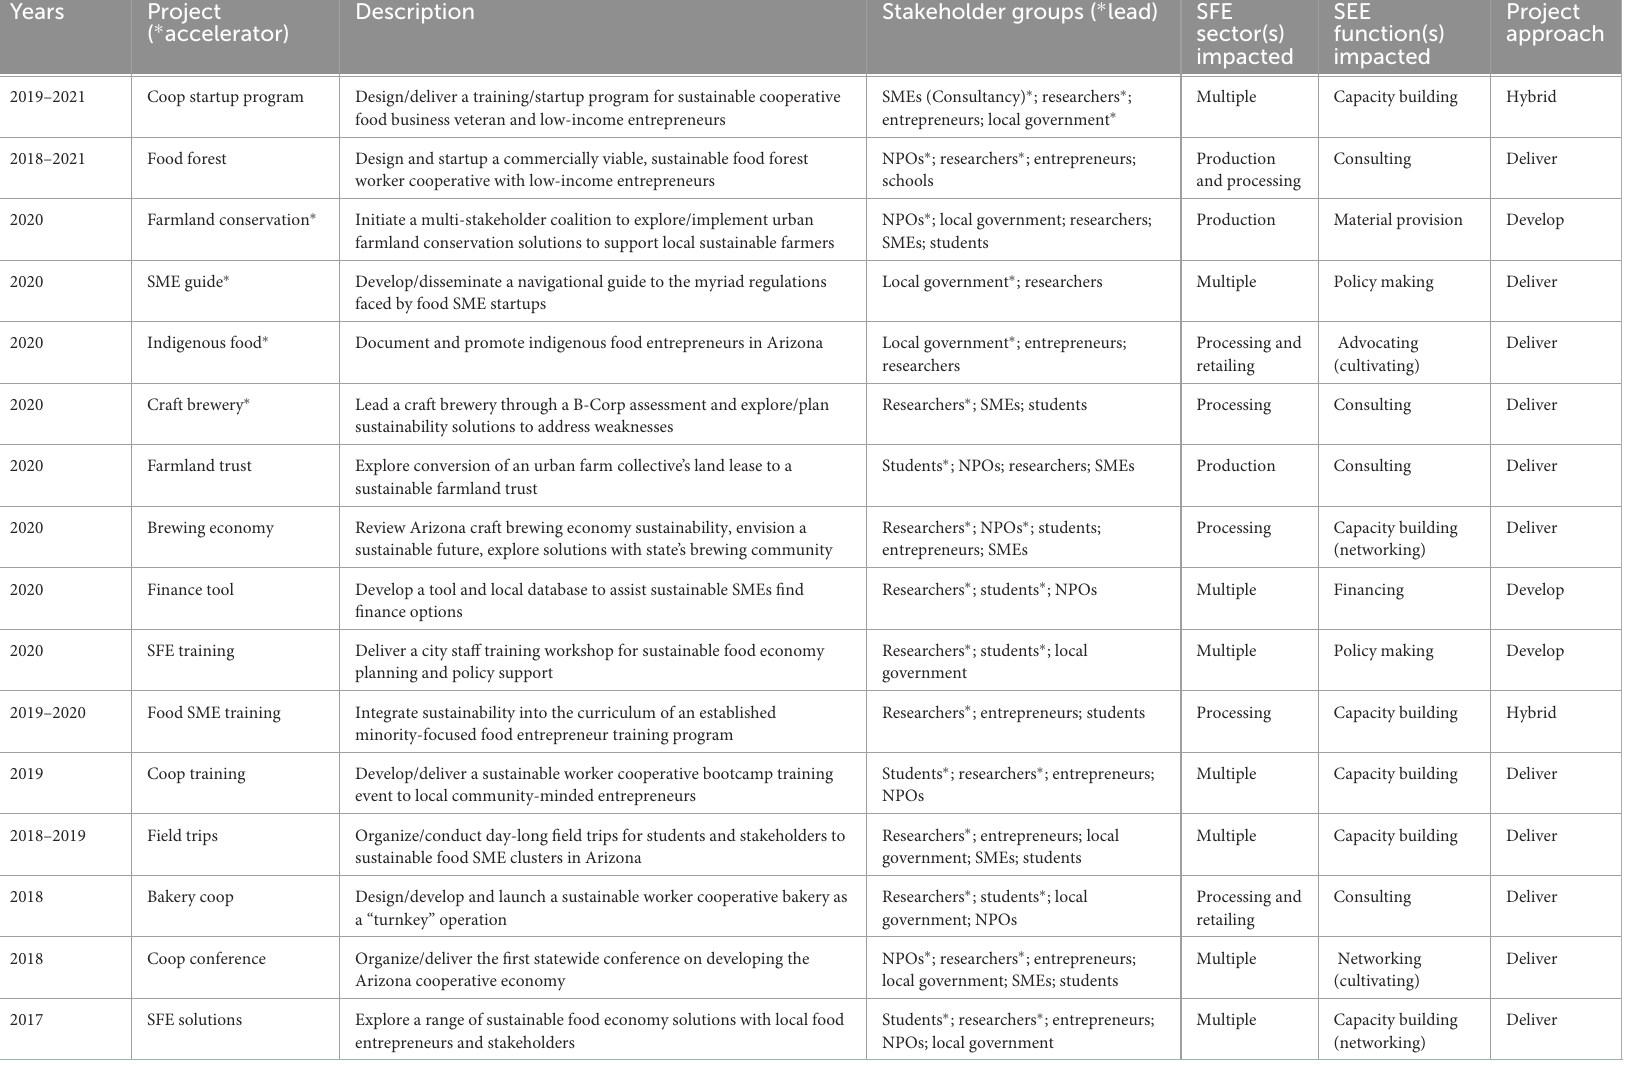
TABLE 1 Projects conducted to advance the Phoenix area sustainable food economy